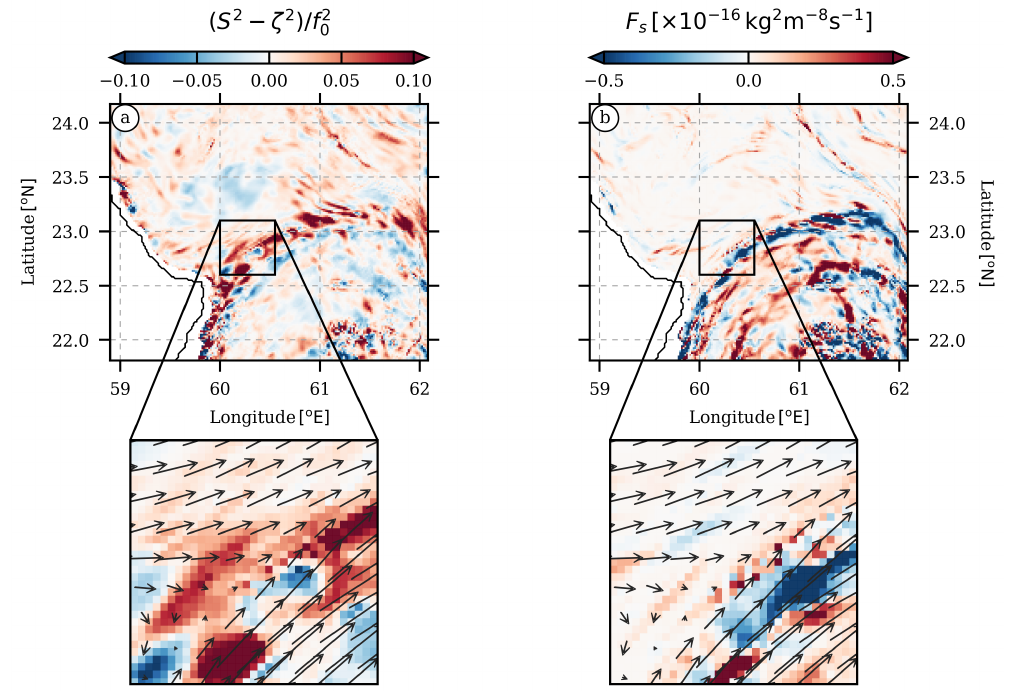
Figure 7. ( a ) Okubo-Weiss parameter and ( b ) frontogenesis function at 250 m depth. Arrows in insets stand for the velocity vector at 250 m